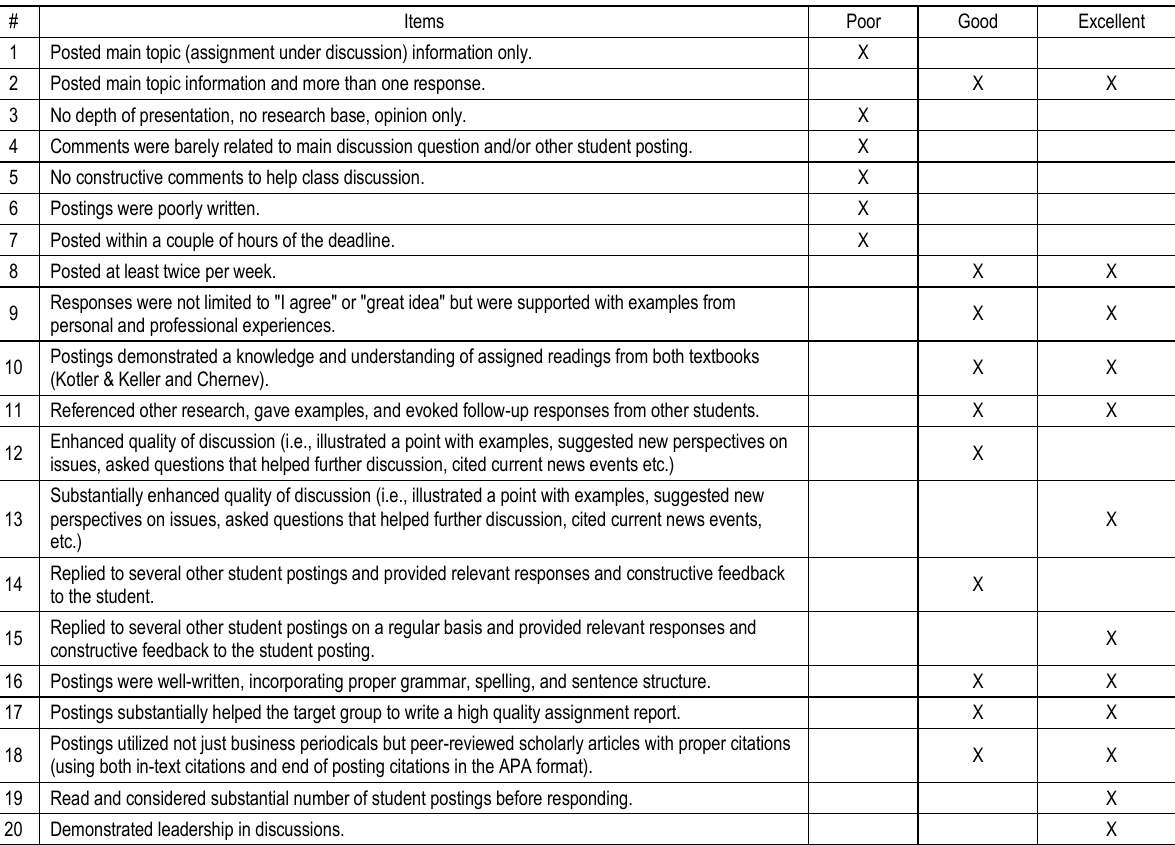
Table 7. A rubric to assess students ’ participation in online across group discussion on assignments This rubric is intended to guide students ’ participation in across group discussion in assignments labeled AXc during Saturdays and Sundays. Here, students help other teams to improve their reports. Students do not turn in any evaluation of across group discussion by their peers. Instead, this rubric is used by your instructor to evaluate students ’ participation in across group discussion. Table 7 is adapted from Hazari (2004), Kayler & Weller (2007) and Alden